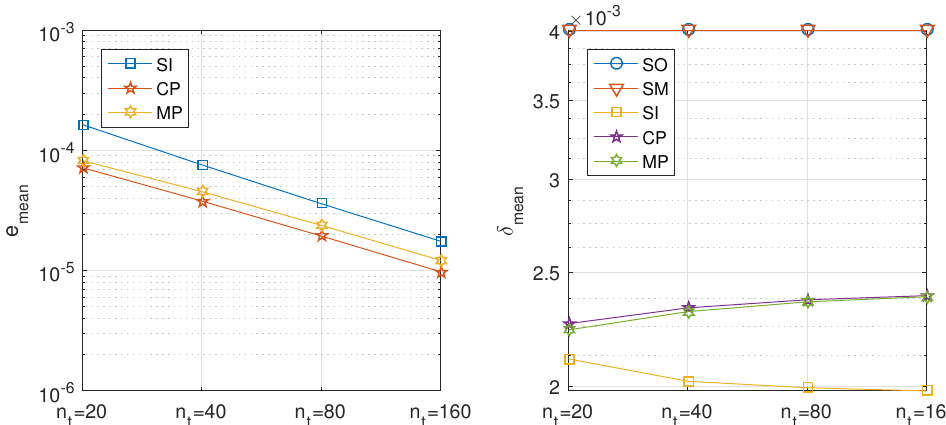
Figure 2. Diffusion problem, directional decomposition. Precision of the proposed methods: sequential iterative SI, classical parallel CP, and modern parallel MP, as compared with the classical ones: sequential operator SO and Strang–Marchuk SM, with second order approximations for the spatial derivatives for different number of time steps.